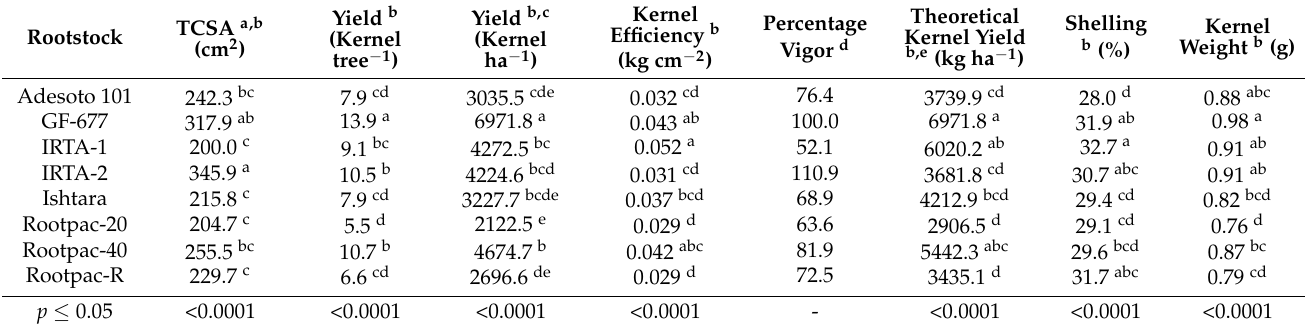
Table 4. Agronomical data at harvest for ‘Vairo’ almond cultivar grafted onto eight different Prunus rootstocks at the IRTA’s Lleida Experimental Station (Borges Blanques, Lleida) in the eighth crop year (2017).